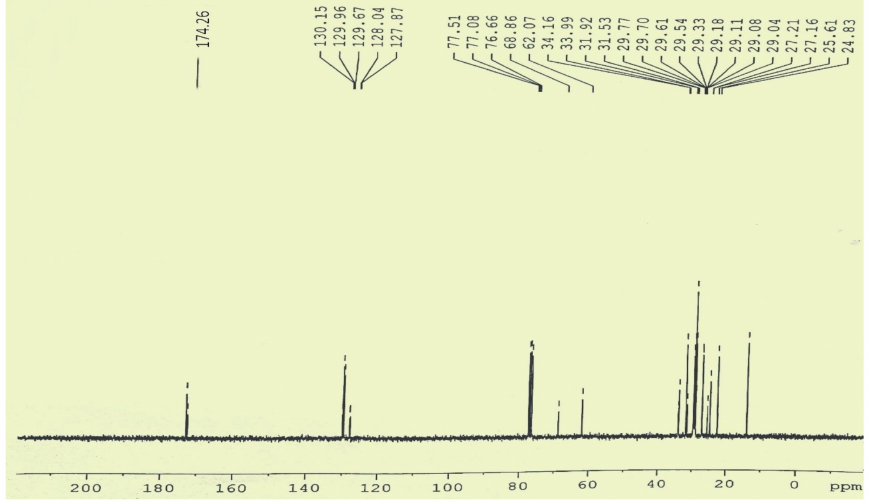
Figure 19. 13 C NMR spectrum of Prunus aitchisonii biodiesel treated with TiO 2